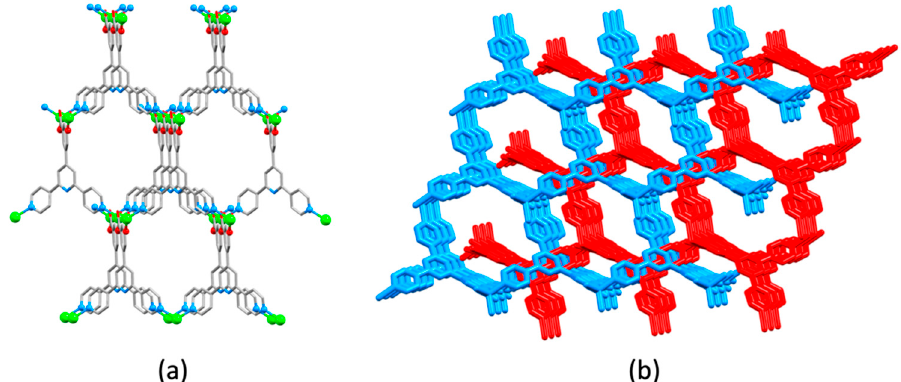
Figure 24. ( a ) Part of one 3D-network in [Zn( 35 )] n with both Zn(II) and the ligand acting at 4-connecting nodes (CSD refcode HOSMEK). The nets in QIDQUS and WUWBUO are identical. ( b ) The 2-fold interpenetration of 3D-nets in [Zn( 35 )] n .